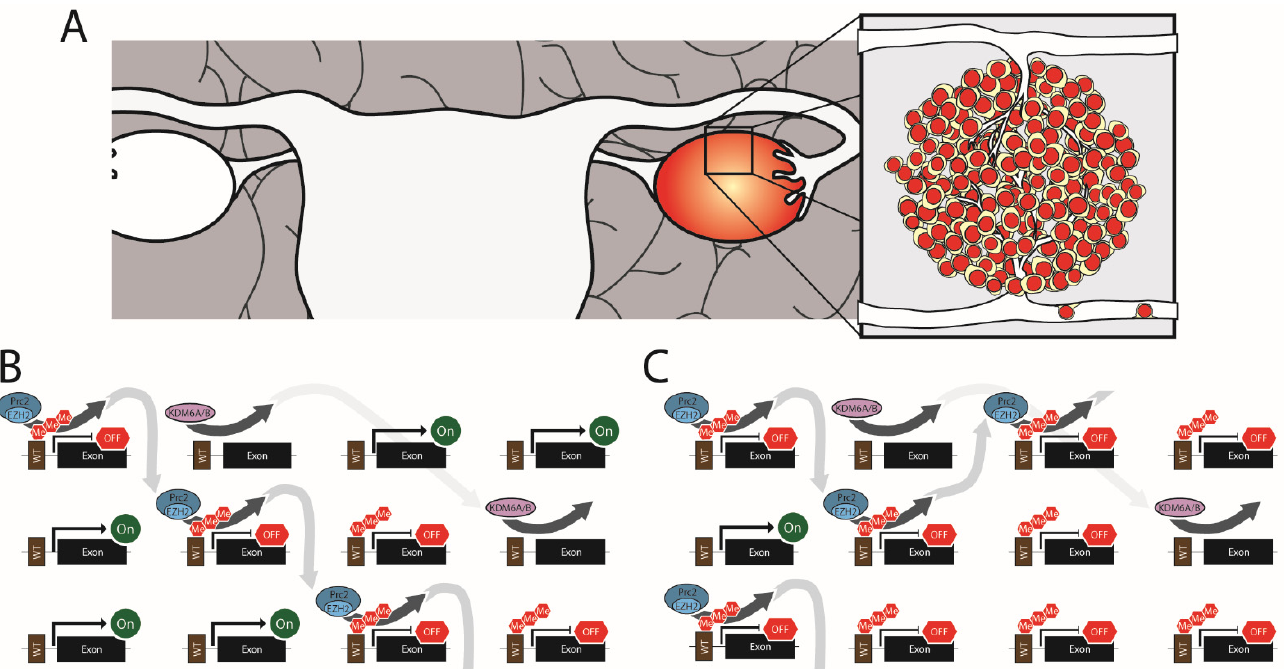
Figure 2. Epithelial Ovarian Cancer. ( A ) High-grade epithelial ovarian tumors arise from the ovaries but become metastatic. ( B ) Normal cells have a balance of PRC2 complexes triple methylating H3K27 and KDM6A/B demethylating H3K27. ( C ) In EZH2 overexpressing ovarian cancer, the system is overwhelmed by excess EZH2 driving excessive H3K27me3 levels and the silencing of genes.